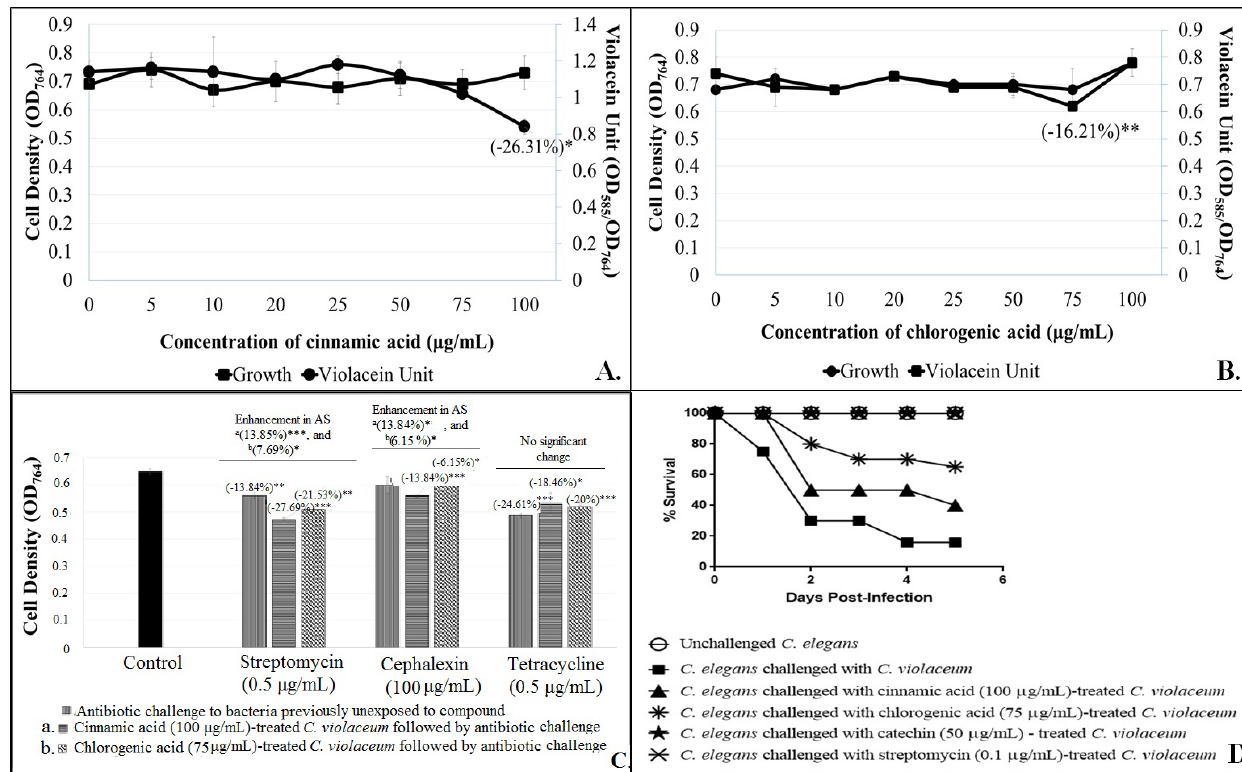
Figure 5. Effect of cinnamic acid and chlorogenic acid on C. violaceum . ‘Control’ in this figure is the vehicle control (0.5%v/v DMSO), which did not exert any effect on growth and violacein production of C. violaceum . ( A ) Effect of cinnamic acid on growth and violacein production in C. violaceum . Bacterial growth was measured as OD ; OD of violacein was measured at 585 nm, and Violacein Unit was 764 calculated as the ratio OD /OD (an indication of violacein production per unit of growth). ( B ) Effect of chlorogenic acid on growth and 585 764 violacein production in C. violaceum . Bacterial growth was measured as OD ; OD of violacein was measured at 585 nm, and violacein 764 unit was calculated as the ratio OD /OD (an indication of violacein production per unit of growth). ( C ) Pre-treatment of C. violaceum with 585 764 chlorogenic acid and cinnamic acid enhances its susceptibility to streptomycin and cephalexin. ( D ) Cinnamic acid, chlorogenic acid,